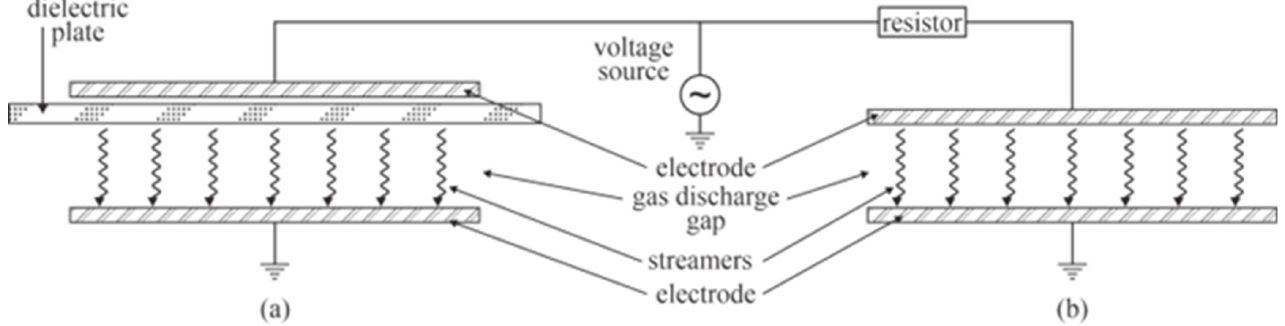
Figure 5. Schematic of the DBD (a) and the corona (b) discharges. The voltage source could be low- frequency RF, alternative current (AC), direct current (DC), or pulsed voltage source. low-frequency RF, alternative current (AC), direct current (DC), or pulsed voltage